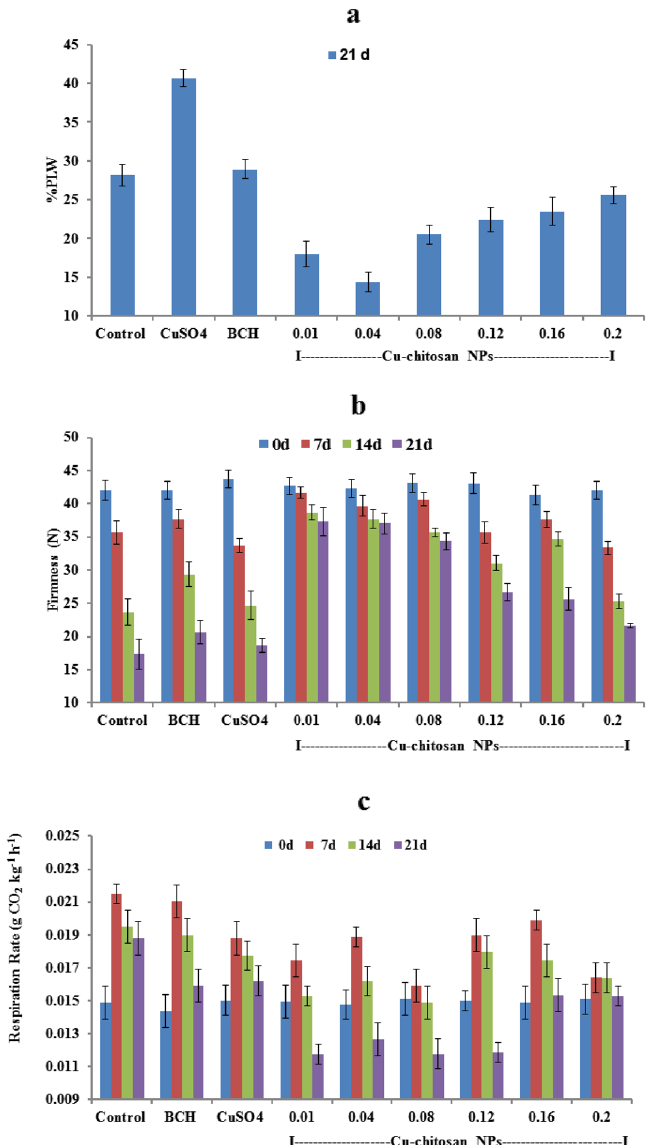
Figure 2. Effect of Cu-chitosan NPs on ( a ) PLW ( b ) firmness ( c ) respiration rate of tomato stored at room temperature. Each value is mean of triplicates and each replication consisted of 5 tomatoes. Control with water. BCH (bulk-chitosan) dissolved in 0.1% acetic acid and CuSO 4 (0.01%) dissolved in water. Error bars represents ± SE (standard